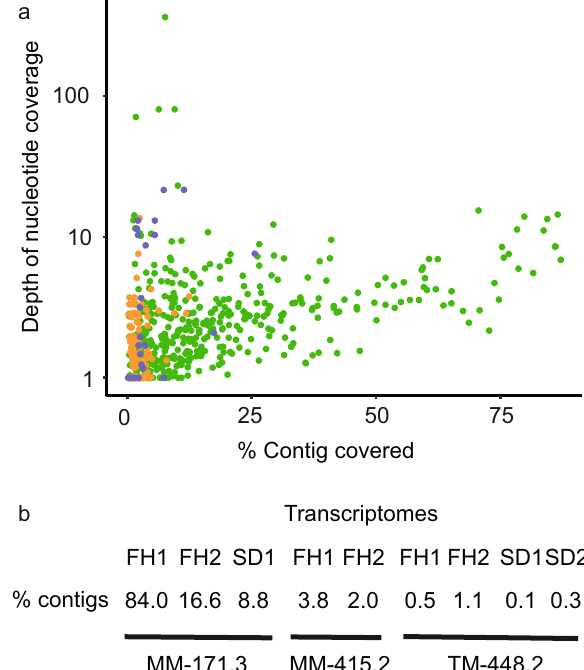
Fig. 3 Transcription-based activity of Äspö HRL viral contigs. Summary of read mappings for the MM-171.3 (green), MM-415.2 (orange), and TM- 448.2 (blue) groundwater metatranscriptomes to viral contigs ( a ). The values in ( b ) give the percentage of contigs recruiting reads (at least one read per contig) from the replicate metatranscriptomes ( n = 2 to 4) for the three groundwater